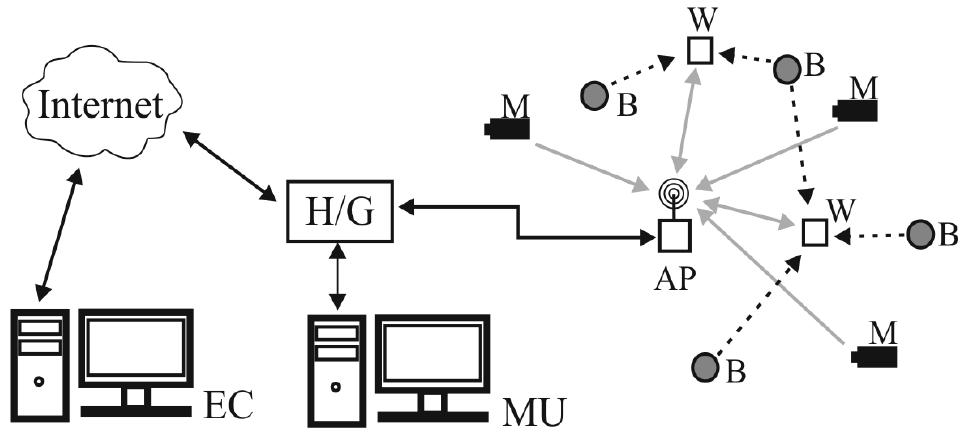
Figure 1. Basic structure of a wireless sensor network for monitoring the work environment and alerting workers to hazards (M—measuring device; W—wearable device; B—Bluetooth beacon; AP—Wi-Fi access point; MU—network main unit; H/G—network hub and gate; EC—external computer; grey arrows—Wi-Fi connections; black dashed arrows—Bluetooth connections; black arrows—Ethernet connections).